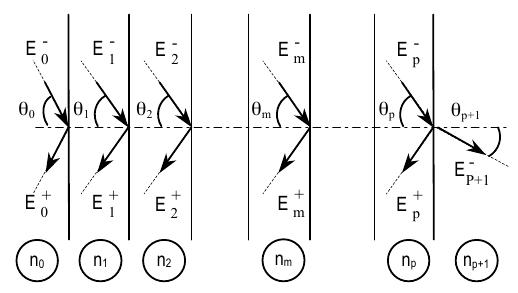
2nd optical window at 0.7034 µ